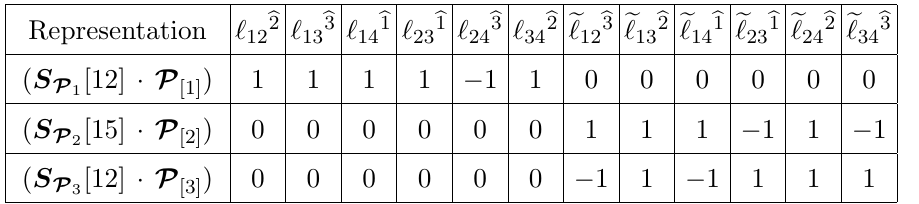
Table 3 . A selection of ‘ and e ‘ values for the three (cid:12)ducial